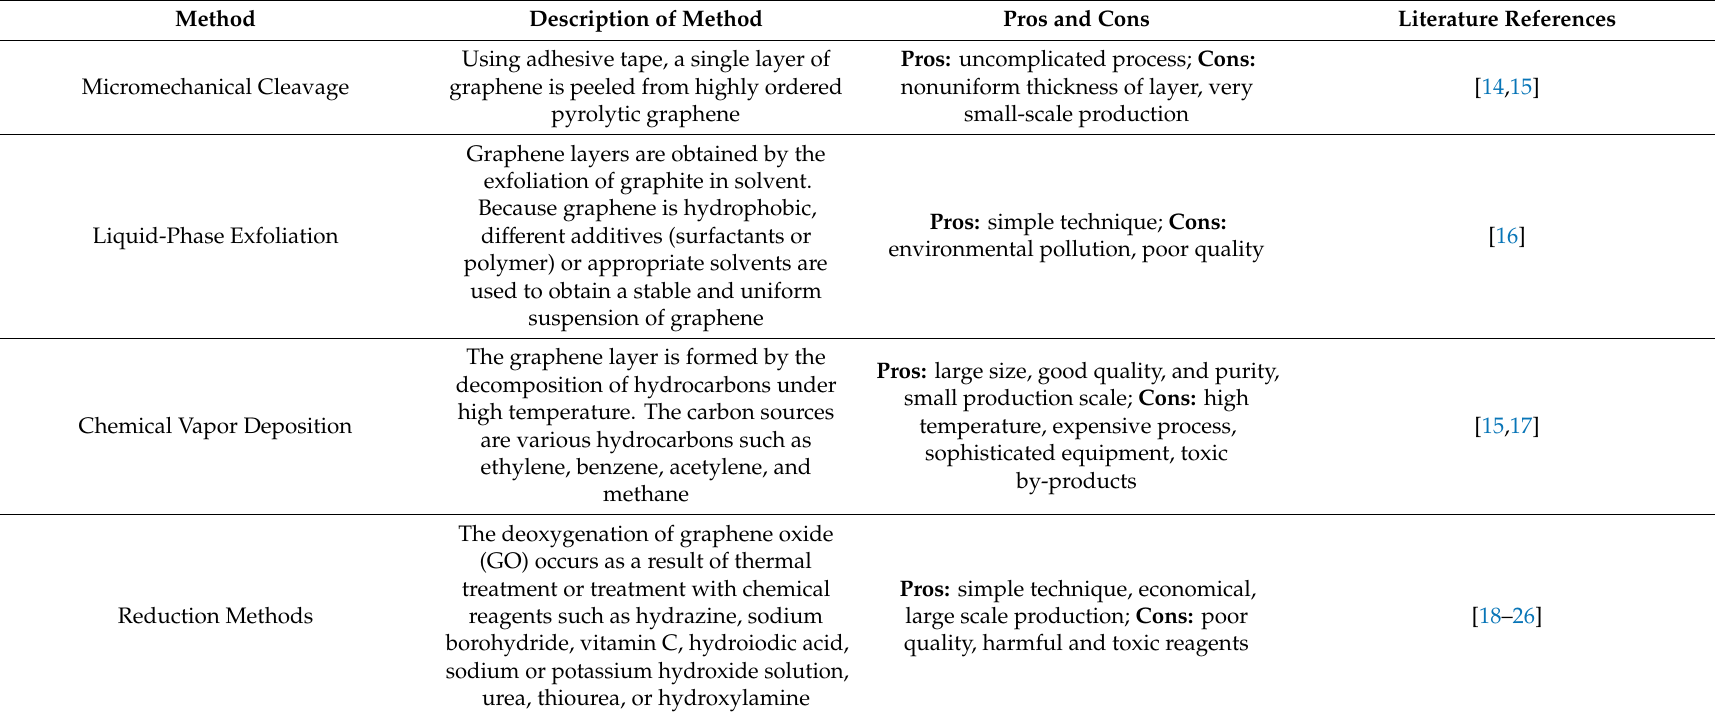
Table 1. Synthetic methods of